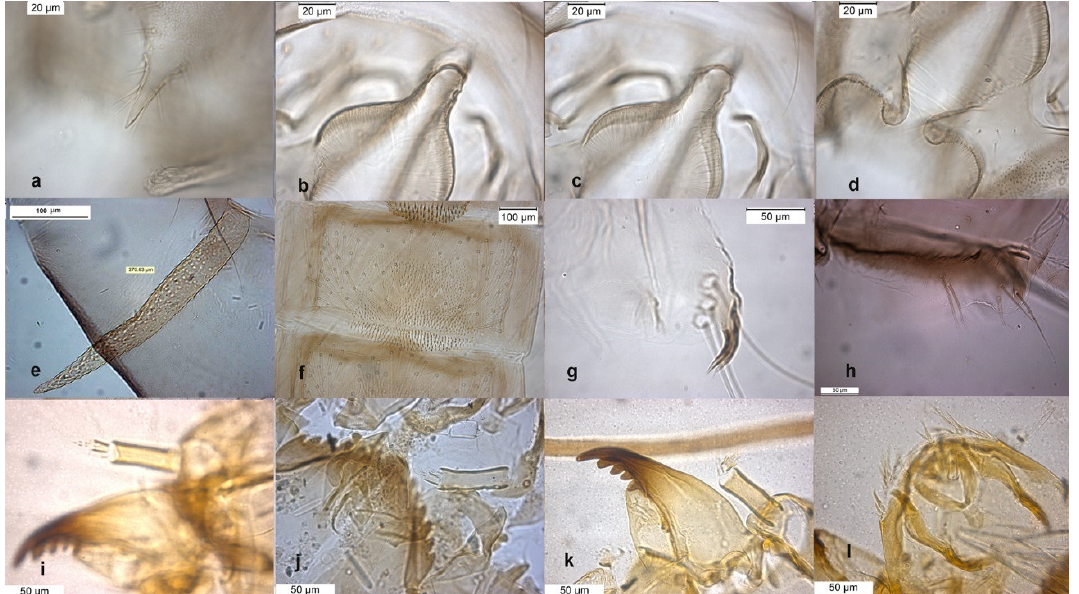
Figure 6. Morphological characters of O. rhyacobius adult male: ( a ) anal point; ( b ) virga; ( c ) superior volsella; ( d ) inferior volsella; pupal exuvia: ( e ) thoracic horn, ( f ) tergite III; ( g ) taeniate extensions; ( h ) tergite VIII; larva: ( i ) antenna; ( j ) mentum; ( k ) mandible; ( l )